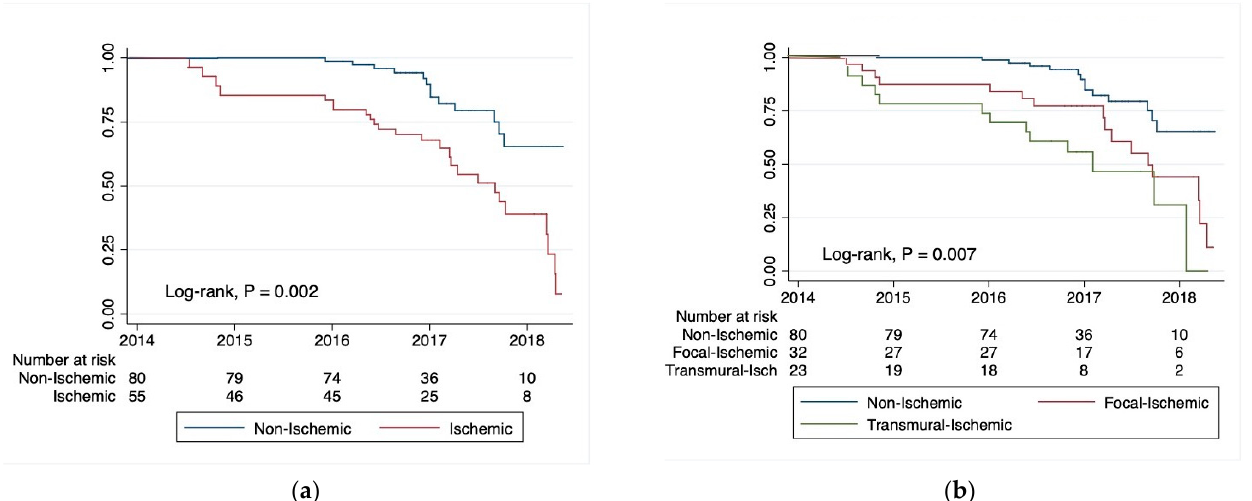
Figure 2. Kaplan–Meier survival estimates for cardiac-related rehospitalizations due to the new oc- currence of acute myocardial infarction (AMI), heart failure (HF), or arrhythmias: ( a ) non-ischemic vs. ischemic CMR LGE patterns; ( b ) non-ischemic vs. focal-ischemic and transmural CMR LGE patterns. Table 3. Independent predictors of cardiac-related rehospitalizations: the new occurrence of acute myocardial infarction (AMI), heart failure (HF), or arrhythmias. Haz. Ratio [95% Confidence Interval] p -Value